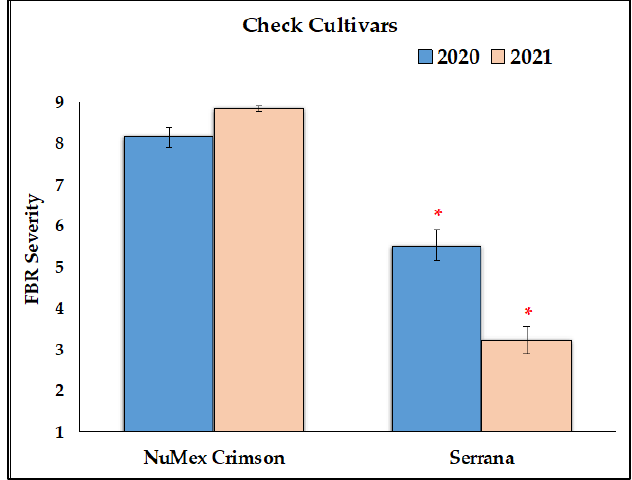
Figure 3. FBR severity of check cultivars in 2020 and 2021, where ‘NuMex Crimson’ is the susceptible check, and ‘Serrana’ is the partially resistant check. Error bars are the standard errors of the mean for FBR severity. * refers to means different from ‘NuMex Crimson’ at p < 0.05.